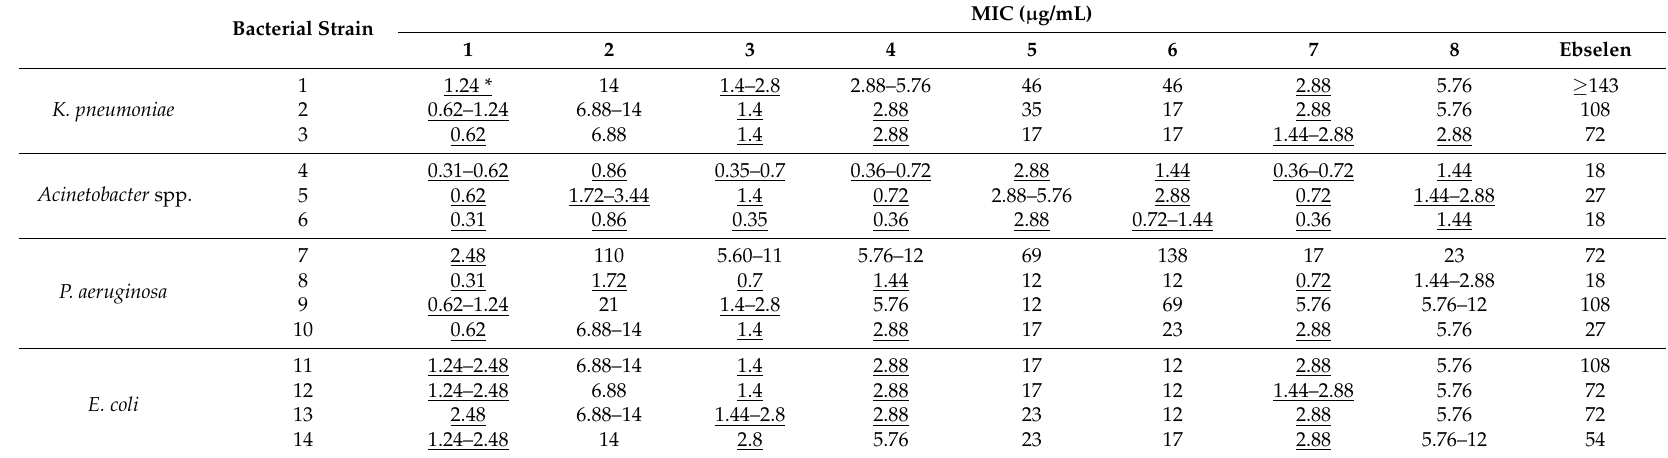
Table 4. MIC values of the compounds 1 – 8 and ebselen against Gram-negative ESKAPE